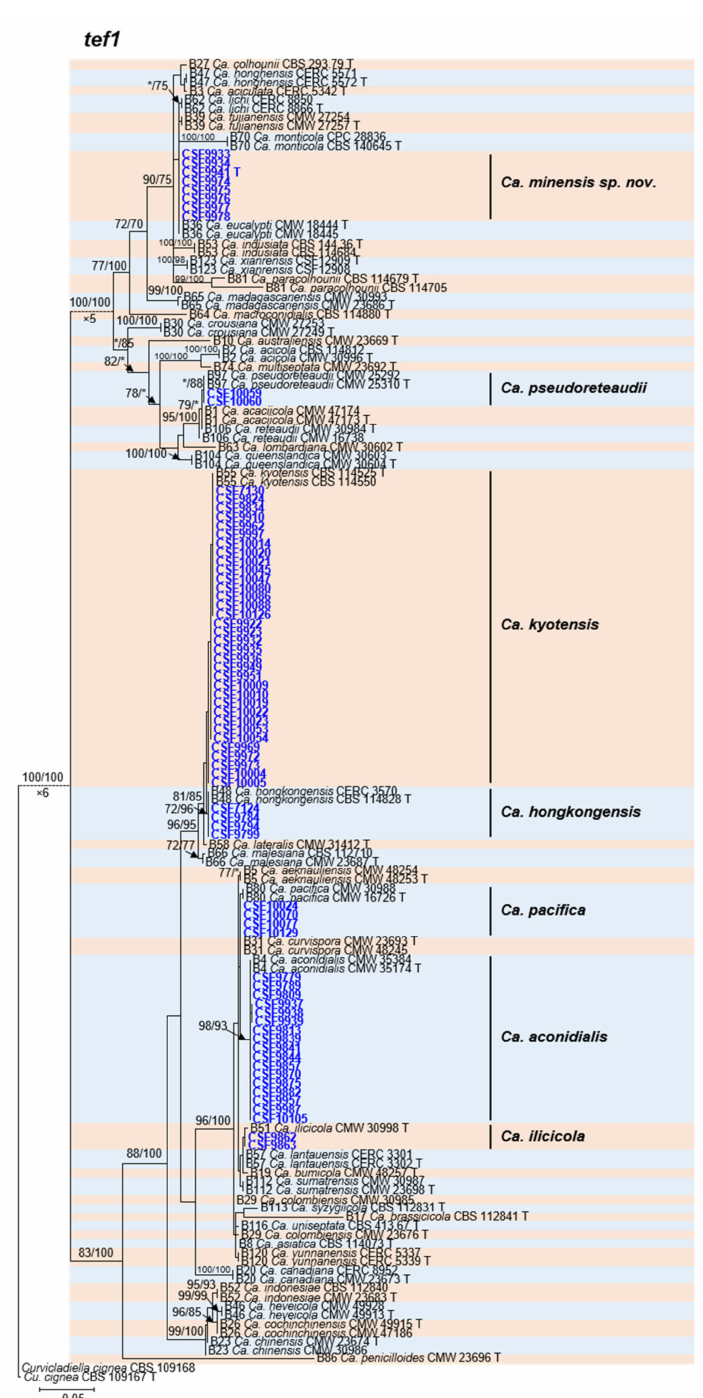
Figure A5. Phylogenetic tree of Calonectria species based on maximum likelihood (ML) analyses of tef1 gene sequences. Bootstrap value ≥ 70% for ML and MP analyses are presented at the branches. Bootstrap values lower than 70% are marked with “*”, and absent analyses values are marked with “-”. Ex-type isolates are marked with “T”. Isolates sequenced in this study are highlighted in blue and bold type. The “B” species codes are consistent with the recently published results in Liu and co-authors [18]. The tree was rooted to Curvicladiella cignea (CBS 109167 and CBS